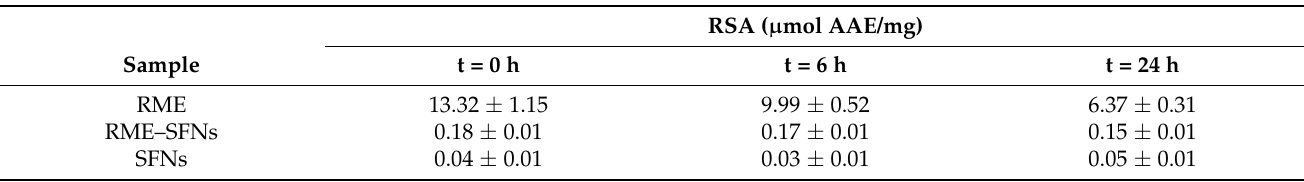
Table 5. Evolution of the Radical Scavenging Activity (RSA) determined by DPPH · Assay after the incubation period of the aqueous suspensions at 37 ◦ C. Values are expressed in µ mol AAE/mg of the